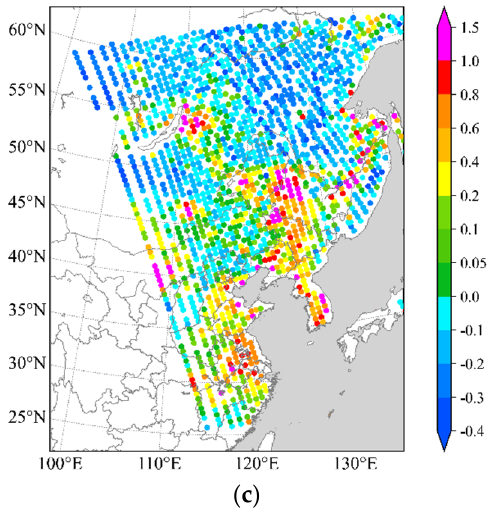
Figure 4. Same as in Figure 2a but for the spatial distribution of the ( a ) numerator, ( b ) denominator, and ( c ) AMSU-A cloud index.